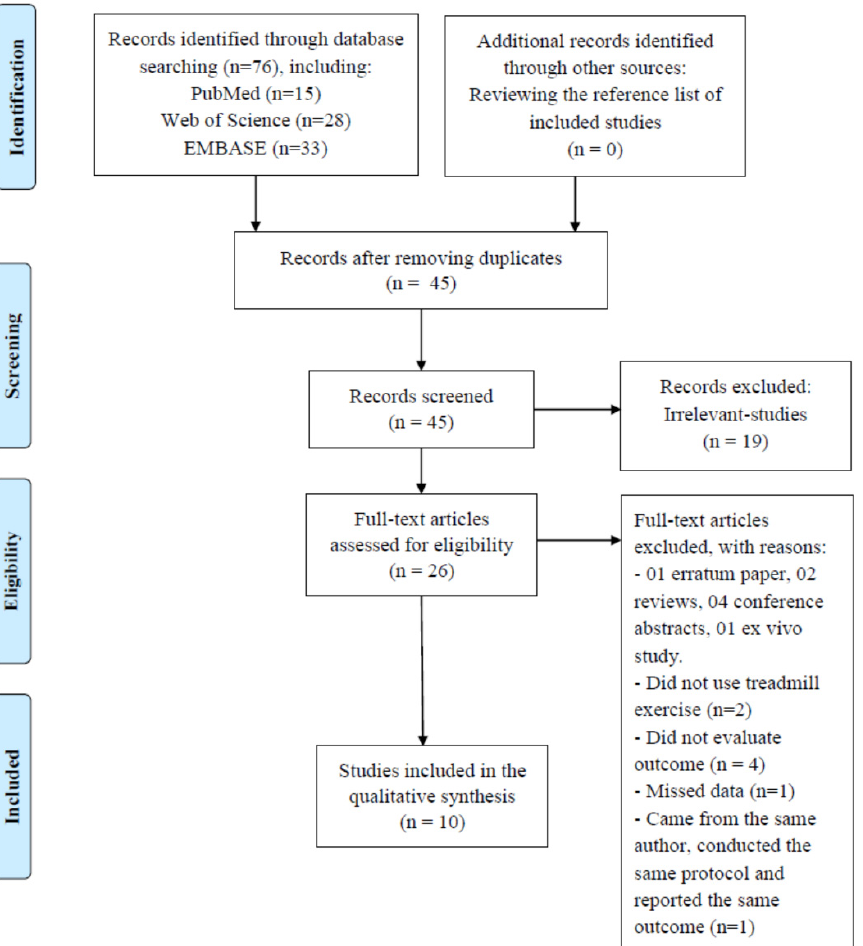
Figure 1. PRISMA flow chart for the selected protocol.